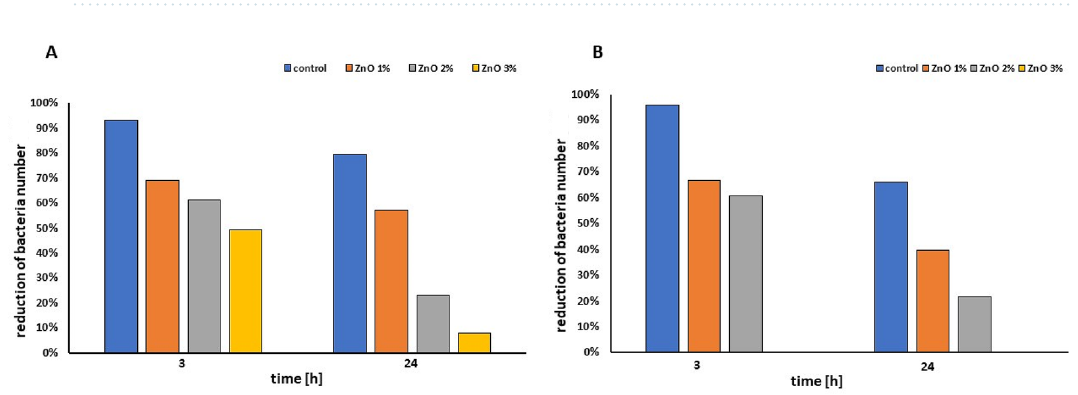
Figure 9. The percentage reduction of bacteria: E. coli ( A ), S. epidermidis ( B ) versus quantity of ZnO in functionalized paper and